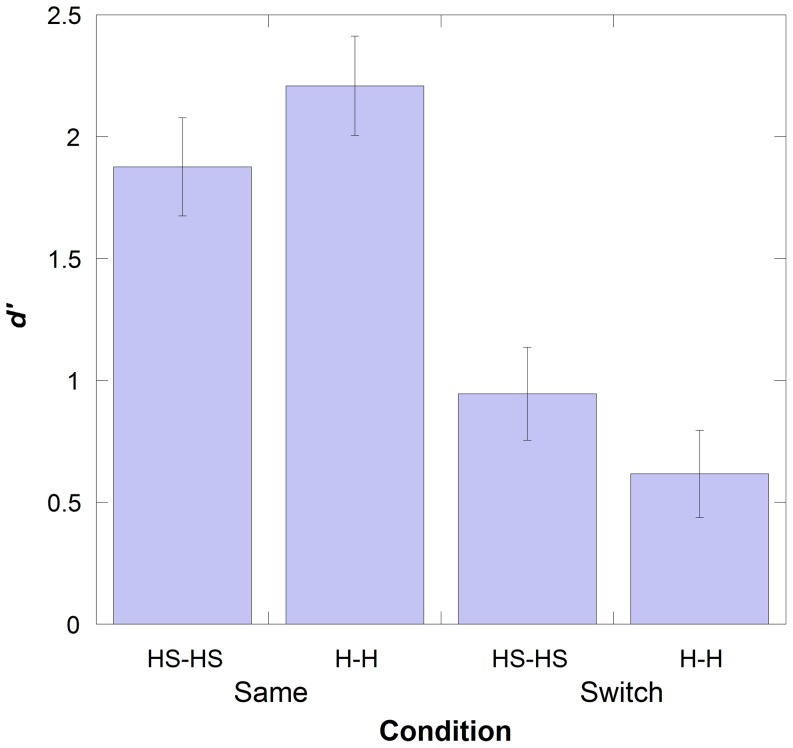
Performance levels in the Same and Switch conditions for Experiment 2 split by the type of trial in each condition.Error bars represent Standard Error. HS-H, (for example), refers to those trials in which the faces that were presented as HS faces in the learning stage were switched and presented with H in the test stage.